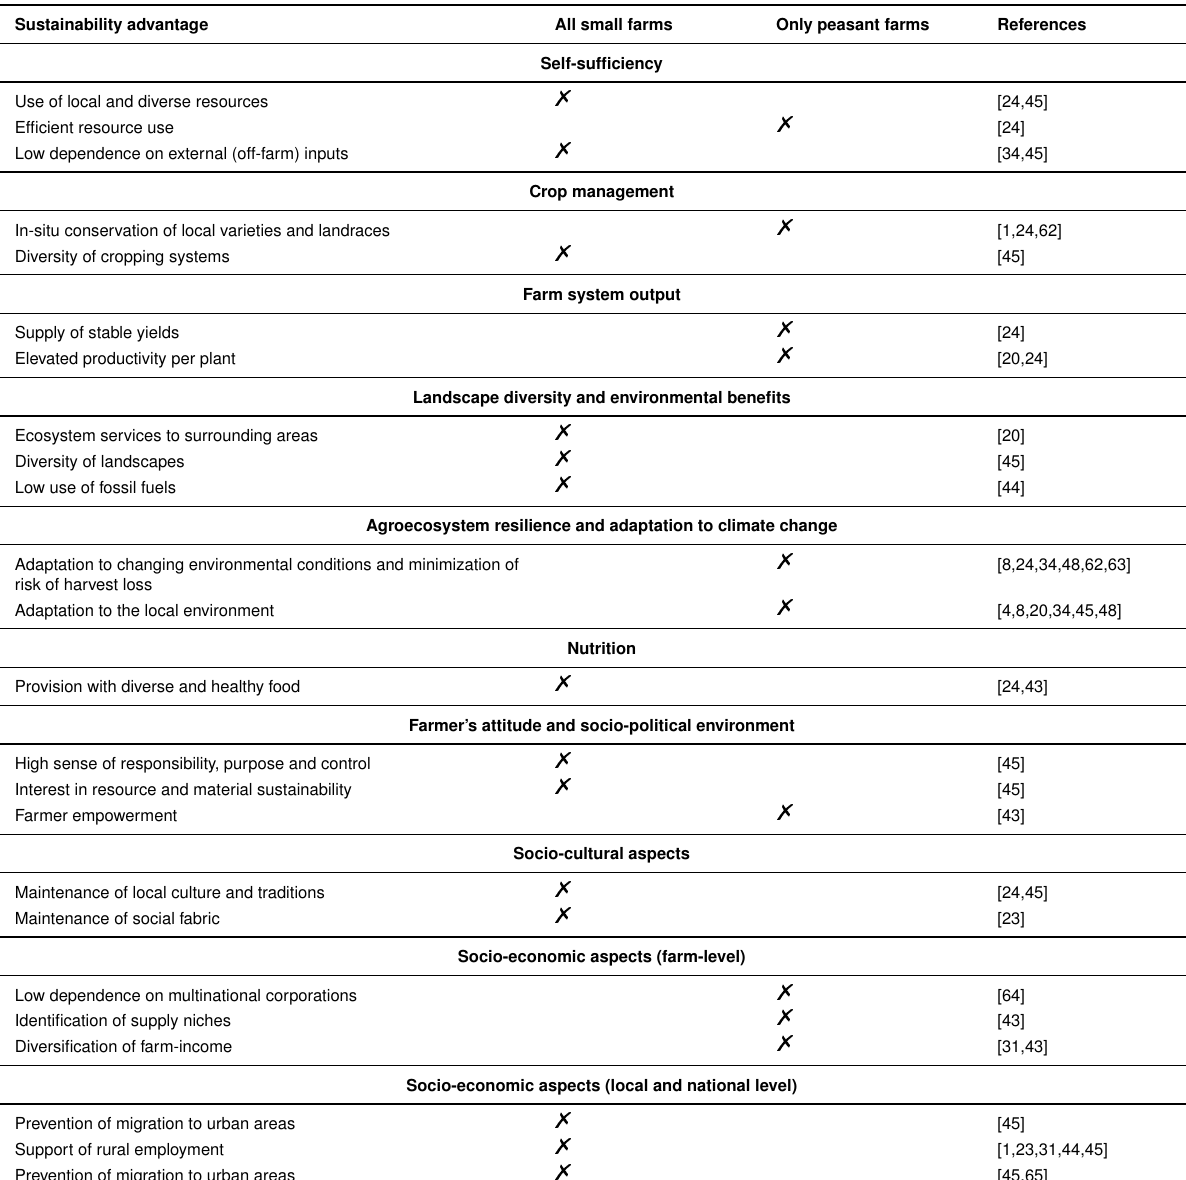
Table 2. Claims of sustainability advantages of small farms (compared to large farms) in publications in the field of agroecology, split into advantages that apply for all farms and only for peasant